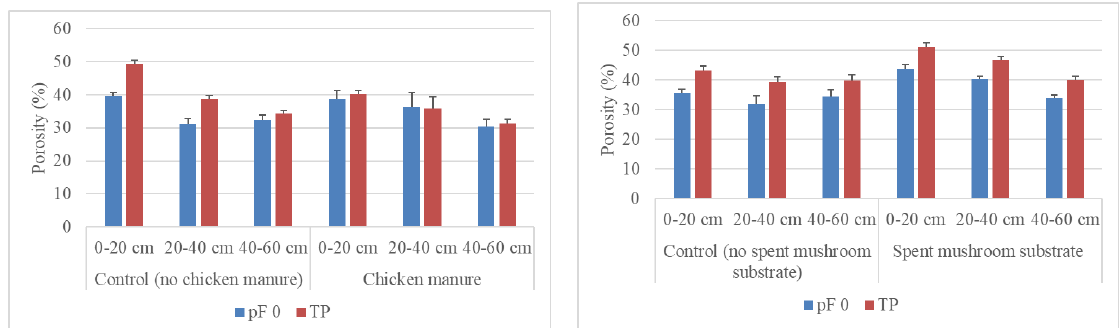
Figure 4. Porosity determined from water retention measurements (pF 0) and porosity calculated from measurements of bulk density and particle density (TP) at depths of 0–20, 20–40, and 40–60 cm. The bars represent standard deviations.